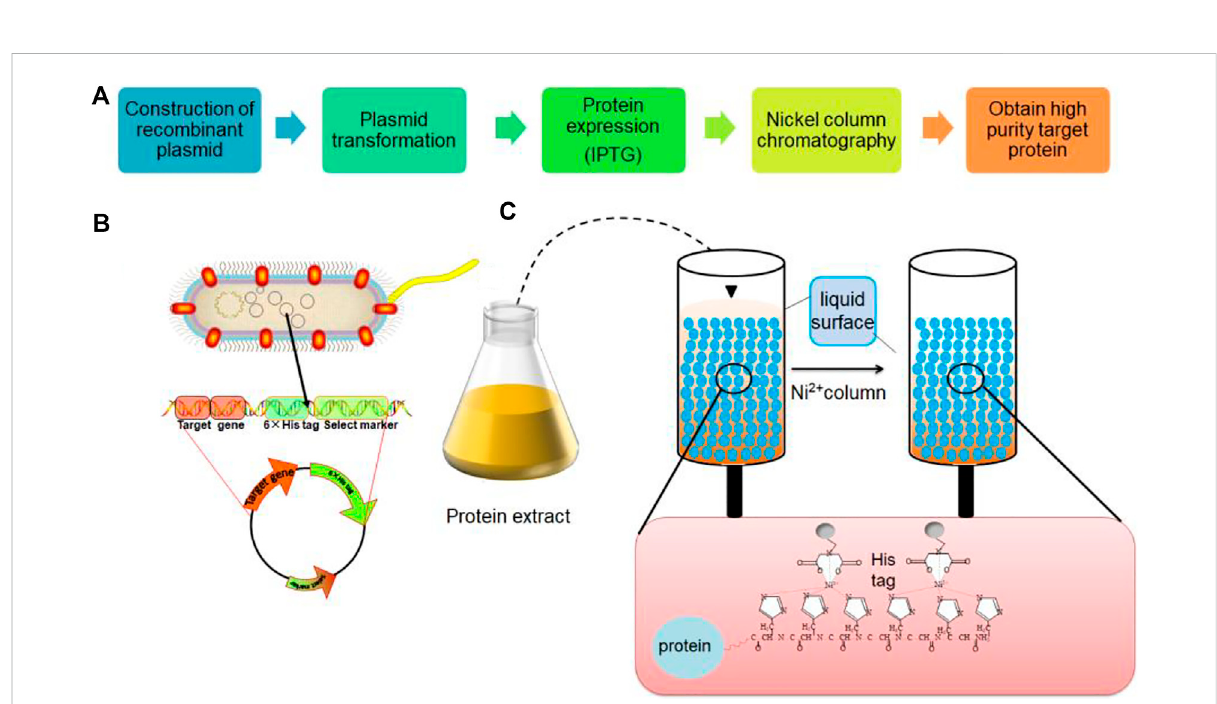
FIGURE 8 Overall fl ow chart of nickel column chromatography. (A) Overall fl ow chart. (B) Plasmid construction transformation. (C) Nickel column chromatography process and his tag structure.